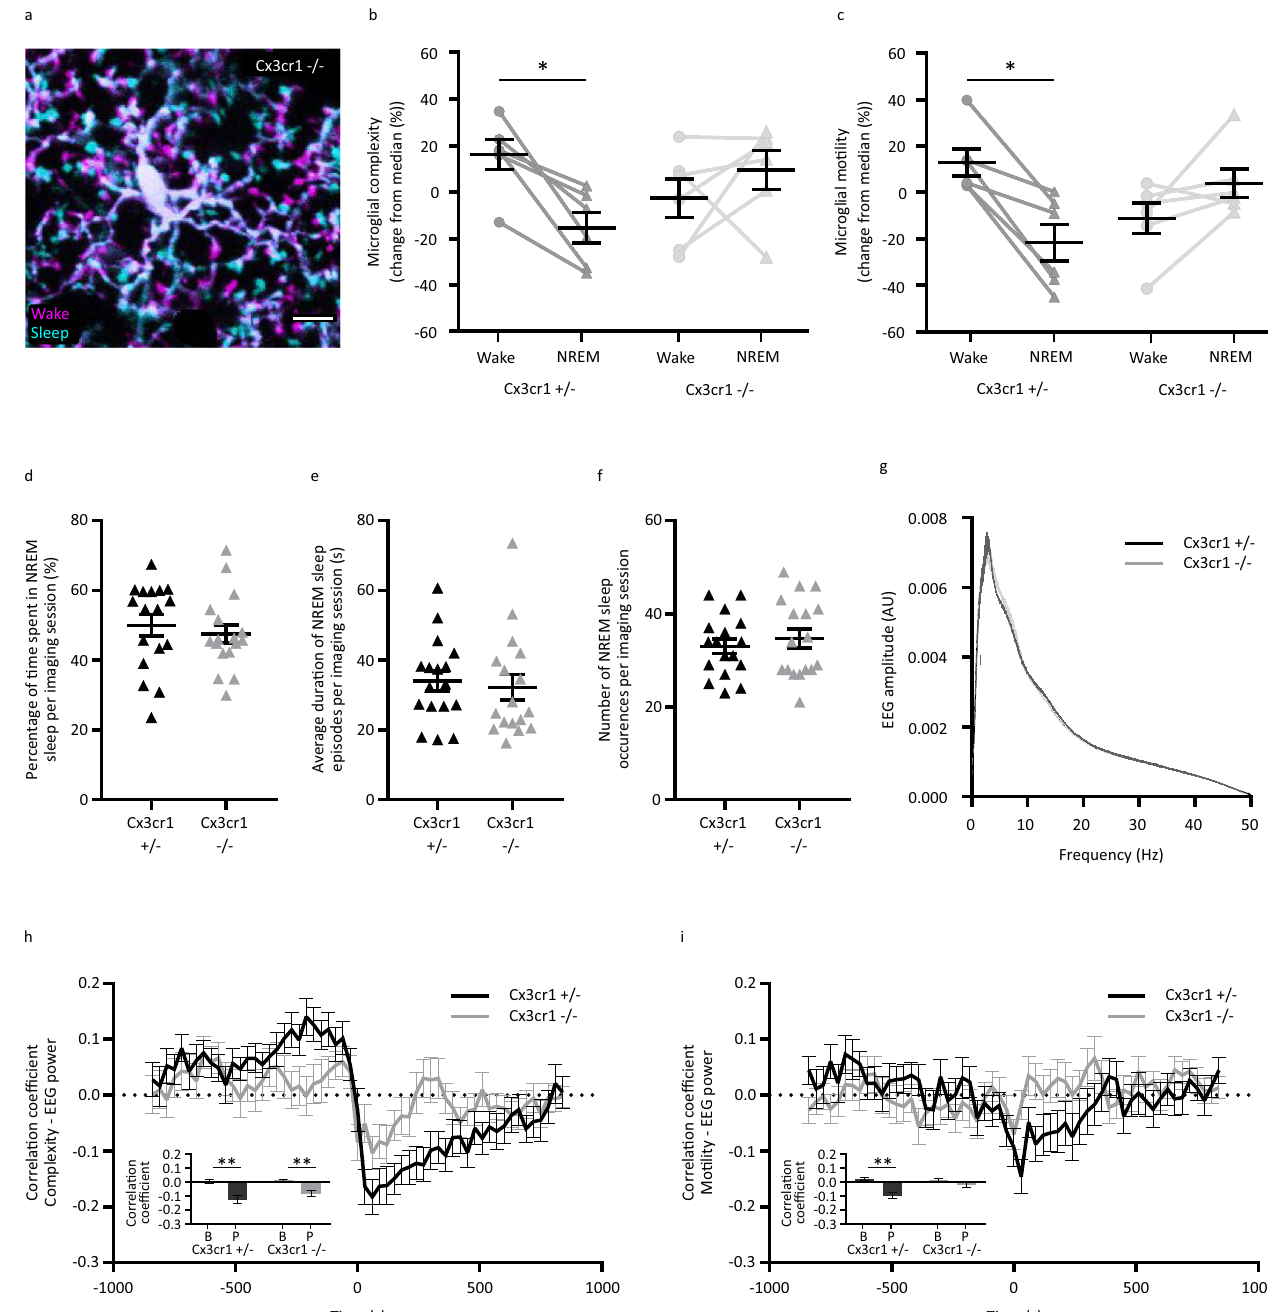
Fig. 5 | Cx3cr1 is involved in the microglial morphodynamics changes during sleep/wake cycles. a Selected frames showing one microglial cell from a Cx3cr1 -/- mouseduringwake(magenta)andsleep(cyan).Scalebar=10 µ m.Quanti fi cationof b microglialcomplexityin Cx3cr1 +/- and Cx3cr1 -/- mice( n =6mice,Wilcoxontest,two- tailed, * p =0.0313 and p =0.4375), and c microglial motility in Cx3cr1 +/- and Cx3cr1 -/- mice ( n =6 mice, Wilcoxon test, two-tailed, * p =0.0313 and p =0.1563) during wake and sleep episodes. Quanti fi cation of NREM sleep during a 35-min imaging session between Cx3cr1 +/- and Cx3cr1 -/- mice through evaluation of d percentage of time, e average duration of individual episodes and f total number of episodes